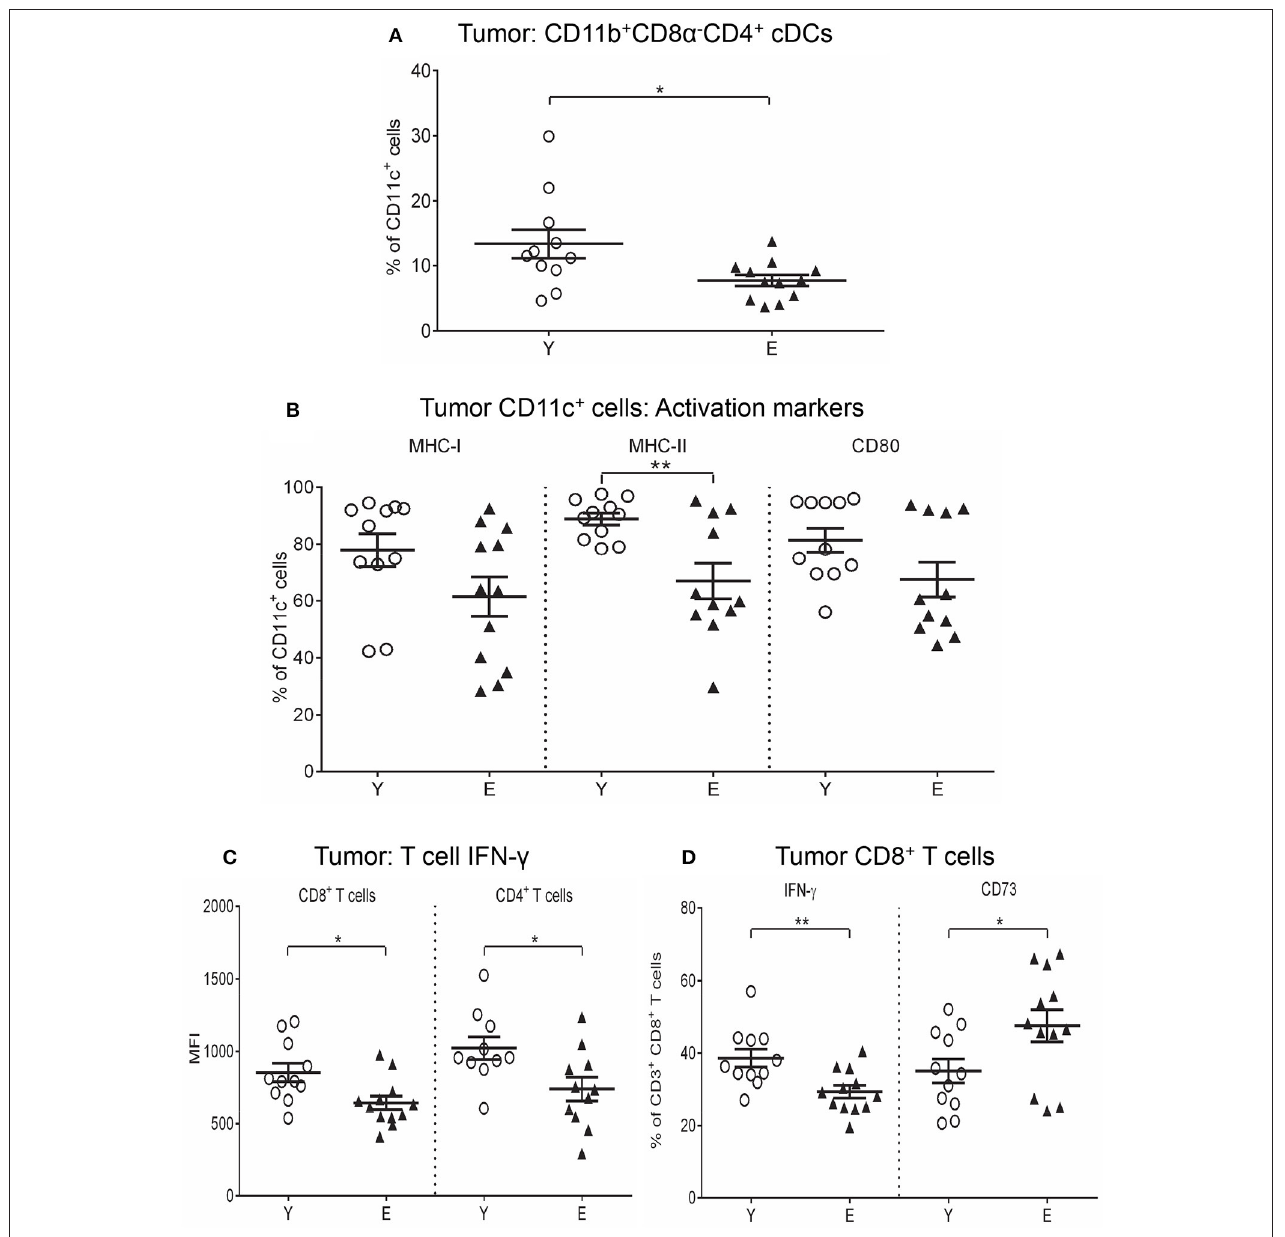
FIGURE 4 | Reduced CD11b + CD8 α − CD4 + cDCs, MHC-I/II, and CD80 on CD11c + cells, and IFN- γ on T cells in elderly tumors. Young and elderly tumors as per Figures 1 , 2 were analyzed using flow cytometry for percentages of CD11b + CD8 α − CD4 + cDCs (A) , percentages of CD11c + cells positive for MHC-I/II and CD80 (B) , IFN- γ expression (shown as geometric mean fluorescence intensity; MFI) on CD8 + and CD4 + T cells (C) , and percentages of CD8 + T cells positive for IFN- γ and CD73 (D) . Data are shown for individual mice as well as mean ± SEM, n = 11 young and n = 12 elderly tumor-bearing mice, * p < 0.05, ** p < 0.005 comparing young to elderly